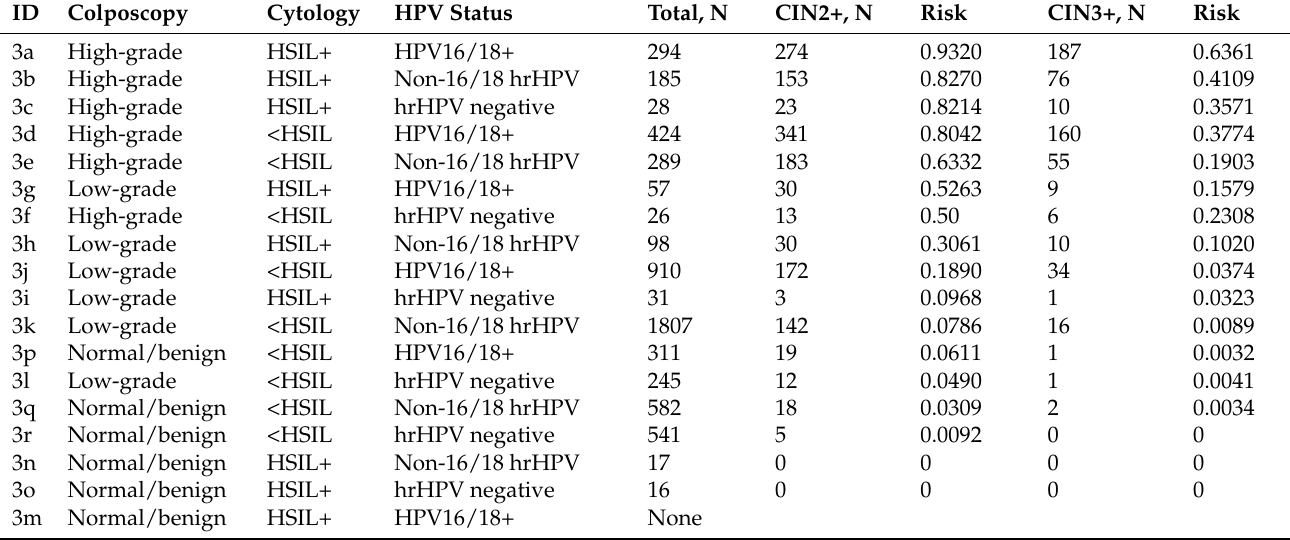
Table 5. Cervical precancers risk strata based on colposcopy, cytology, and HPV